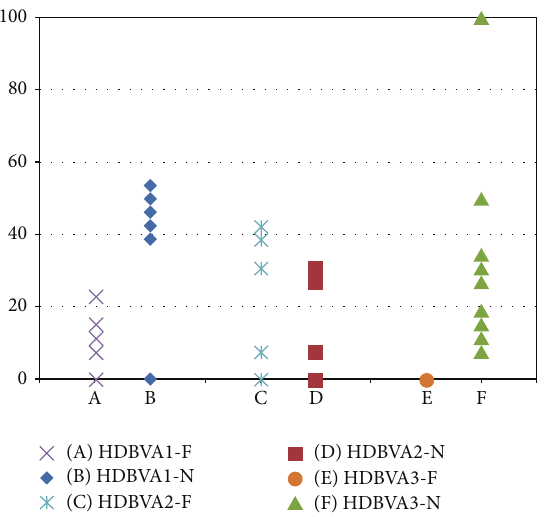
Figure 12: In-range slider displacement percentages of case Figure